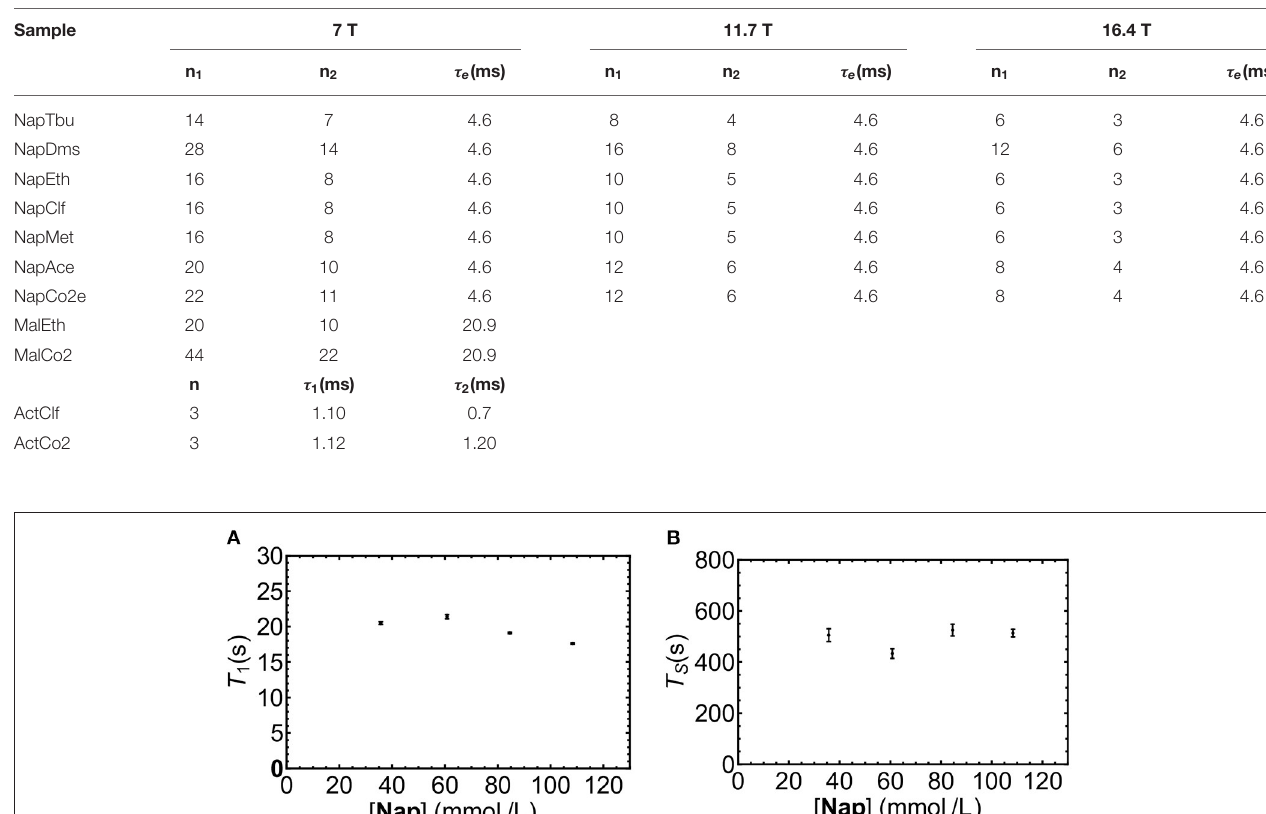
TABLE 2 | Experimental values of the pulse sequence parameters used for the various samples in measuring T S with the pulse sequence in Figure 4 .